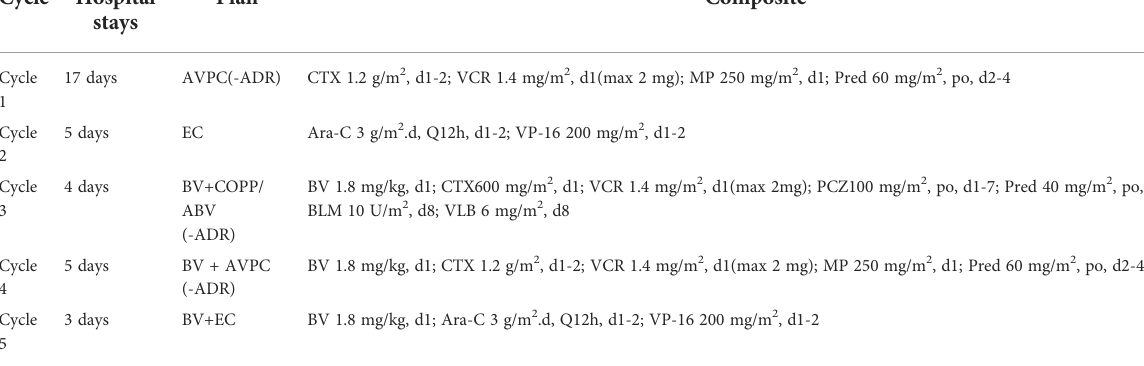
TABLE 2 Chemotherapy schedule and dosage.